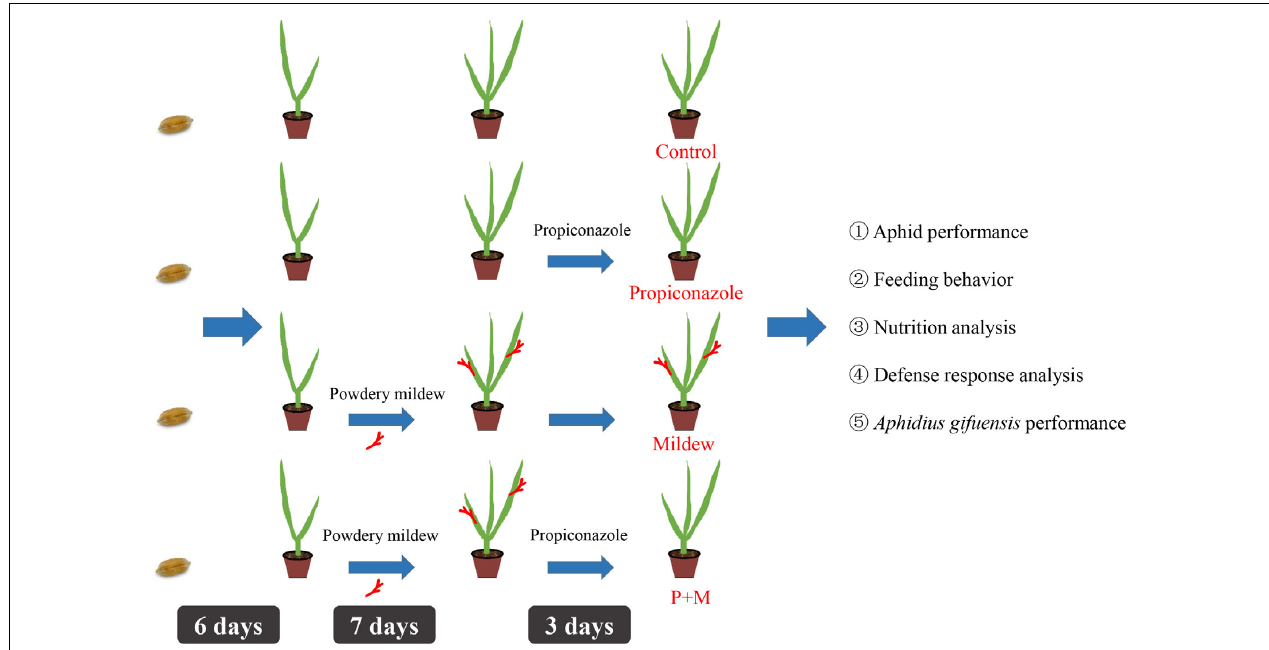
FIGURE 1 | Timeline indicating important time points in the experiment investigating how the presence of Mildew on wheat affects the performance of S. avenae and its natural enemy – a parasitic wasp Aphidius gifuensis .